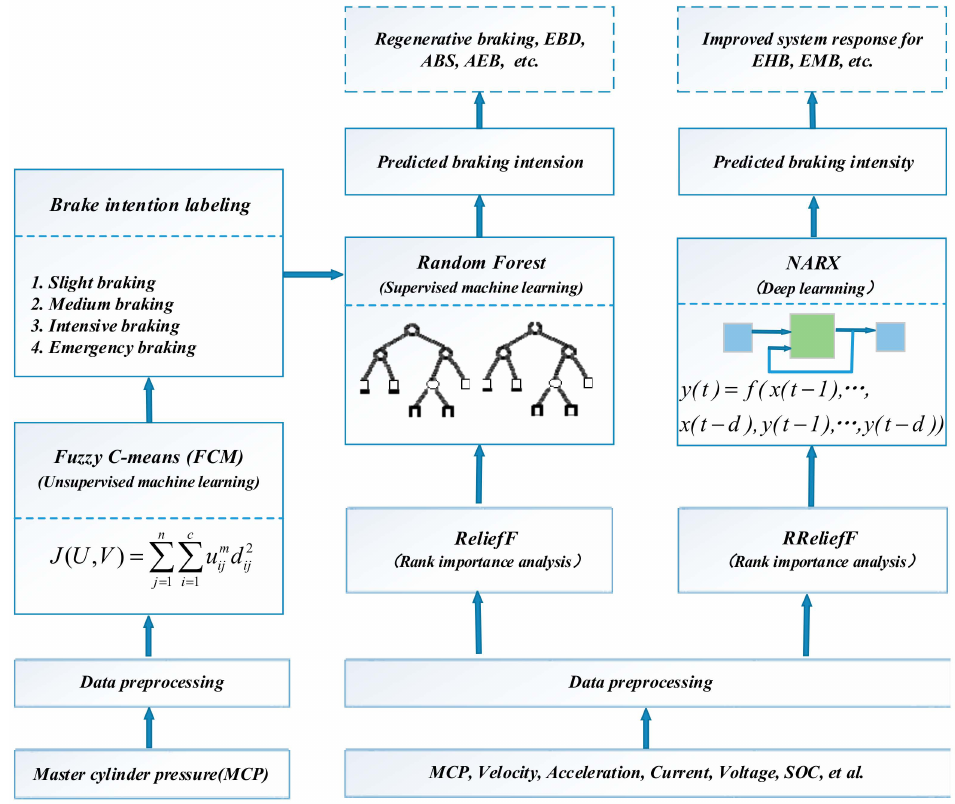
Figure 3. Systematic framework of brake intention and intensity prediction using a hybrid machine learning